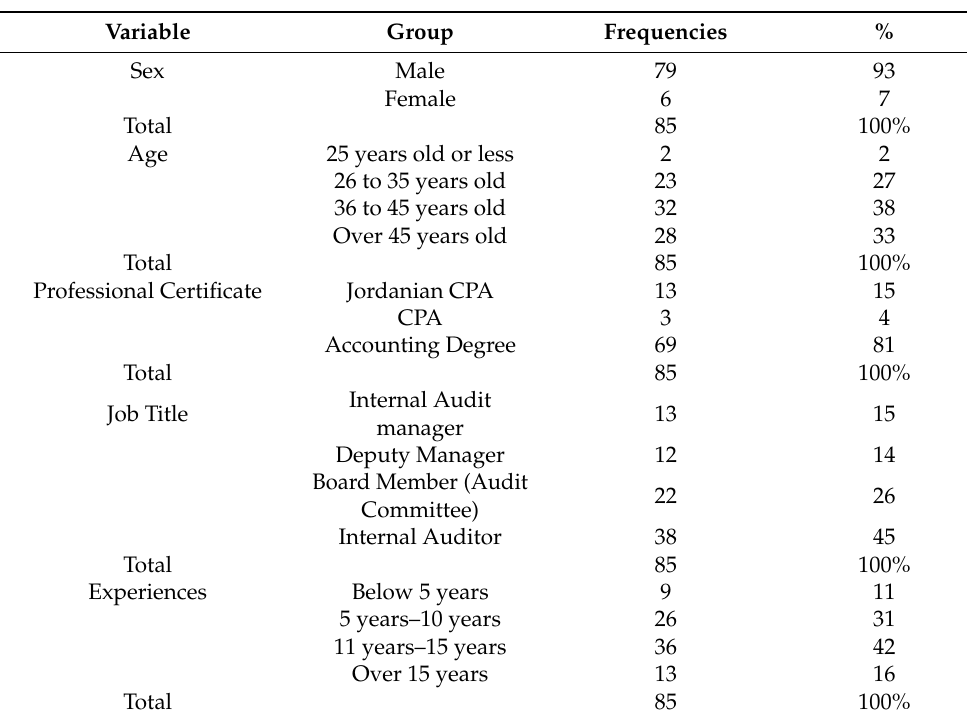
Table 3. Demographic